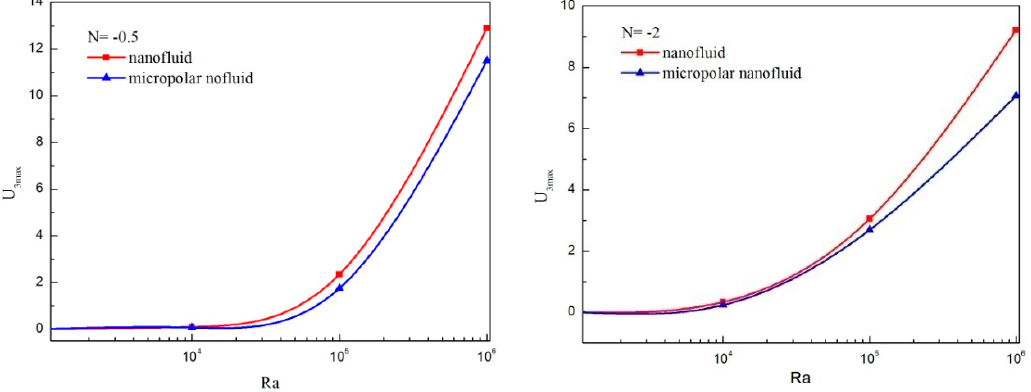
Figure 8. Variations of U 3max versus Rayleigh number for both micropolar and non-micropolar